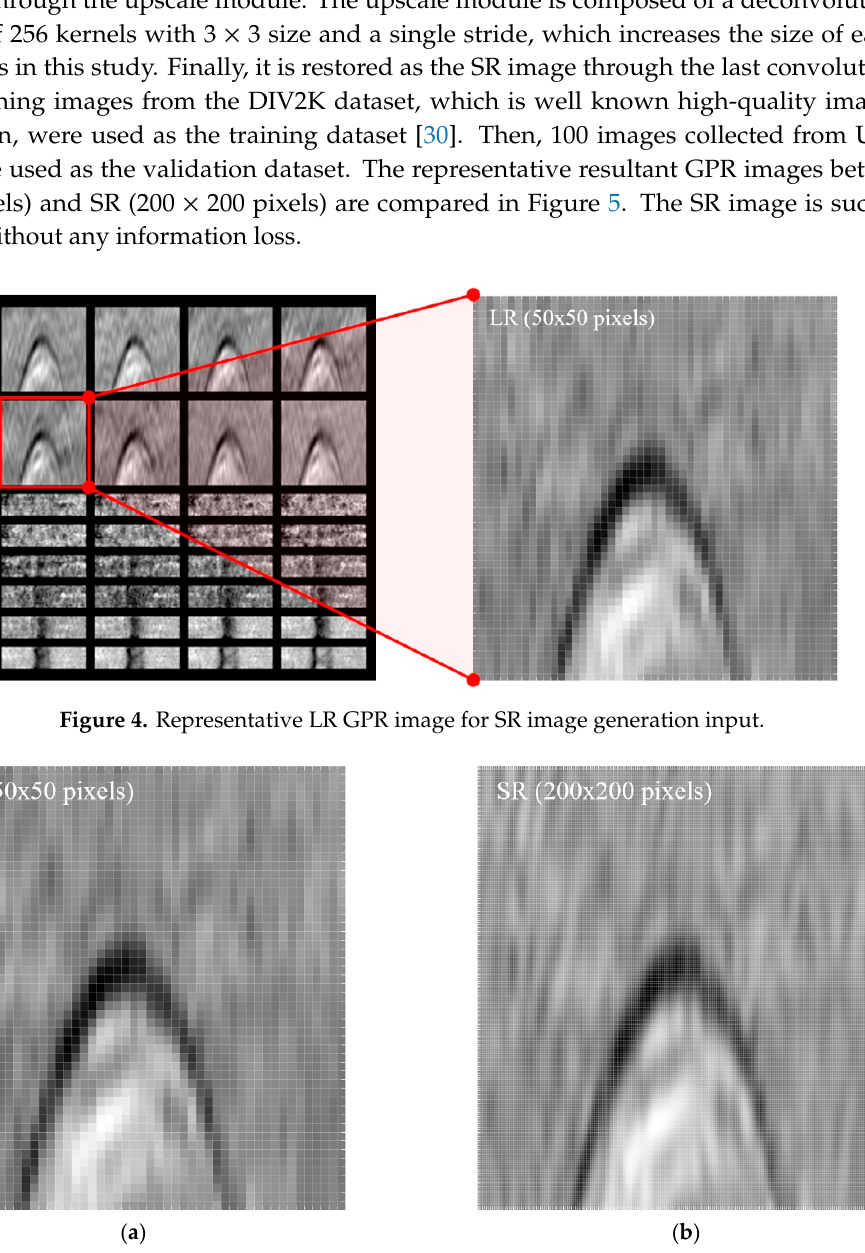
Figure 5. GPR image enhancement results: ( a ) LR and ( b ) SR images.